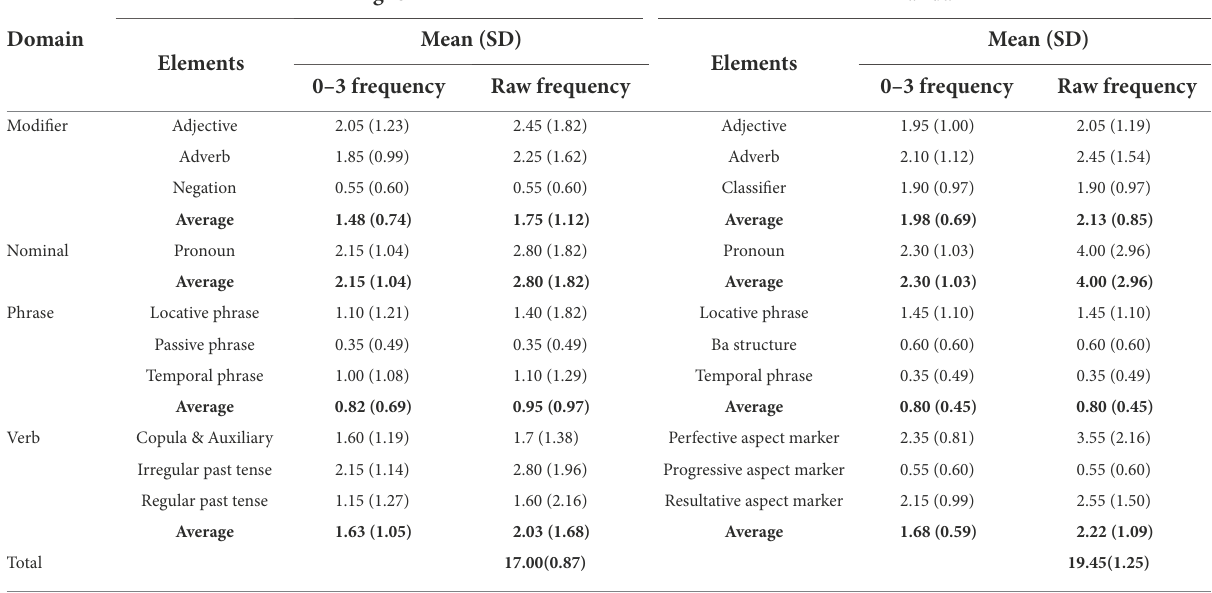
TABLE 4 Within language analysis of microstructure across domains for English and Mandarin in frequencies (0–3 and raw frequency).